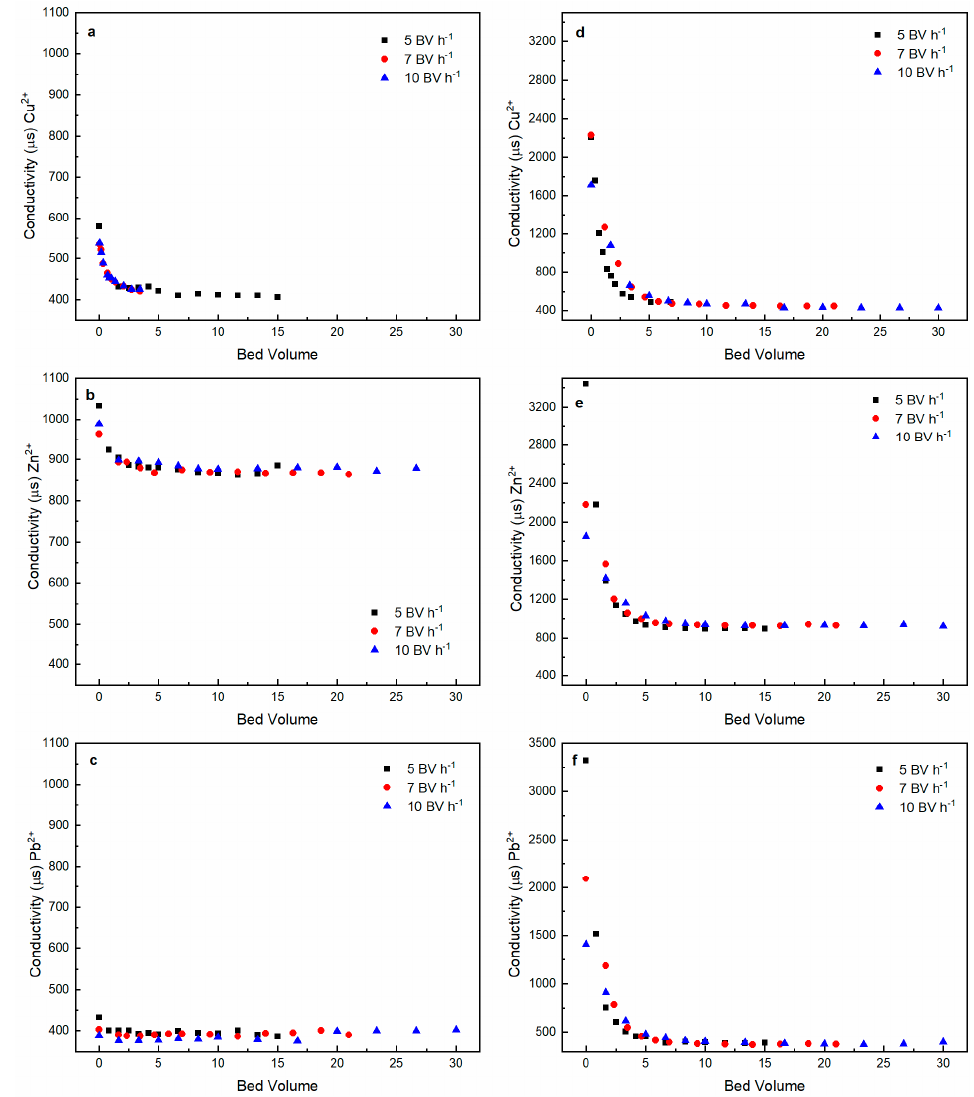
Figure 4. Conductivity studies of using clinoptilolite leaching Cu 2+ ( a ); Zn 2+ ( b ); Pb 2+ ( c ) and zeolite A leaching Cu 2+ ( d ); Zn 2+ ( e ); Pb 2+ ( f ).